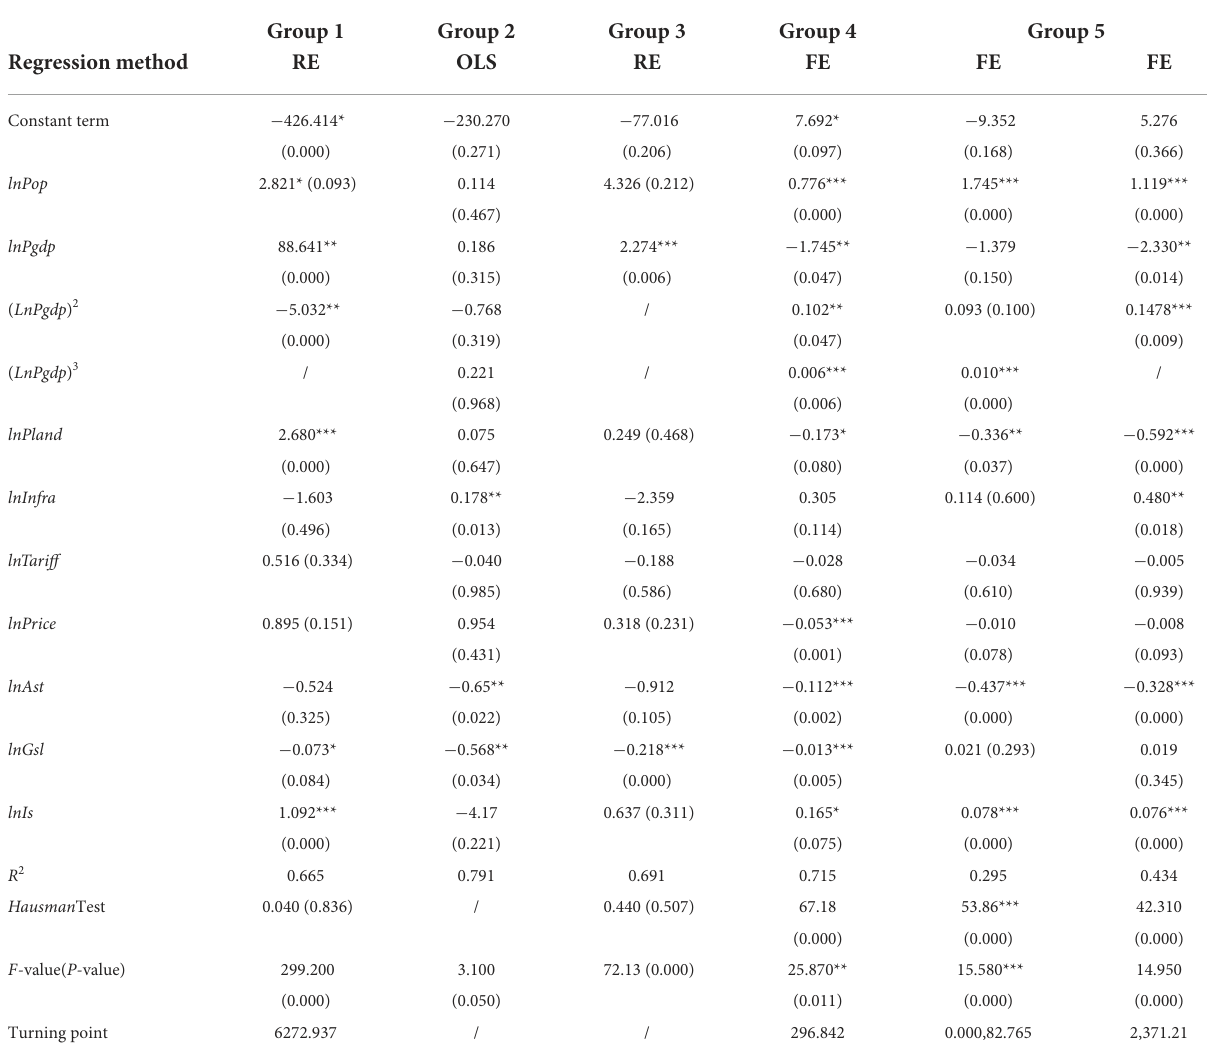
TABLE 7 Model regression